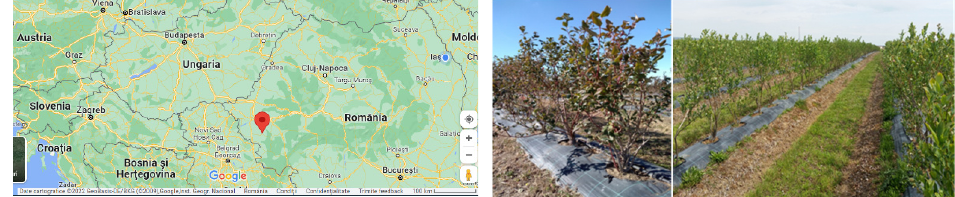
Figure 1. Experimental site (Gherteni ş town; 45°25 ′ 48 ″ N 21°34 ′ 55 ″ E, Cara ş -Severin County) .